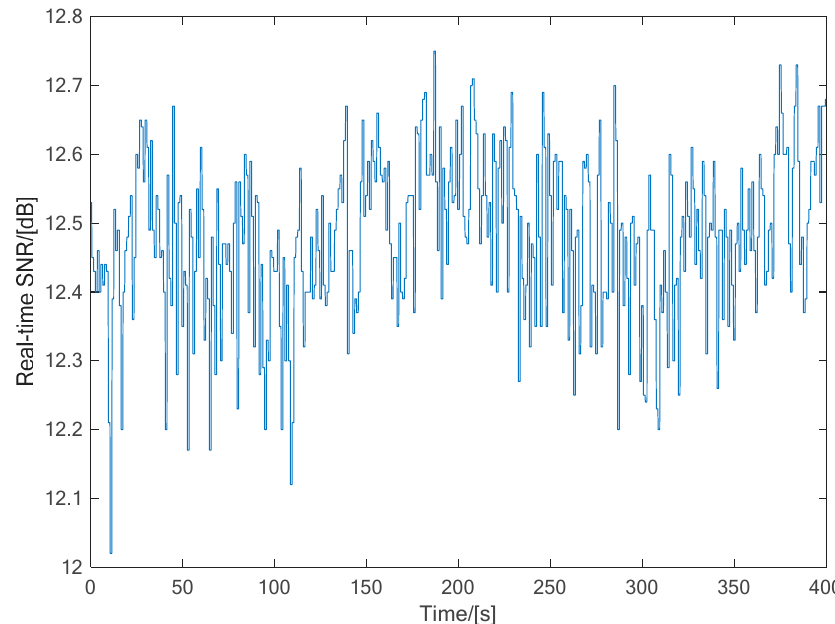
Figure 18. Real-time SNR of SOTM of the method in this paper.